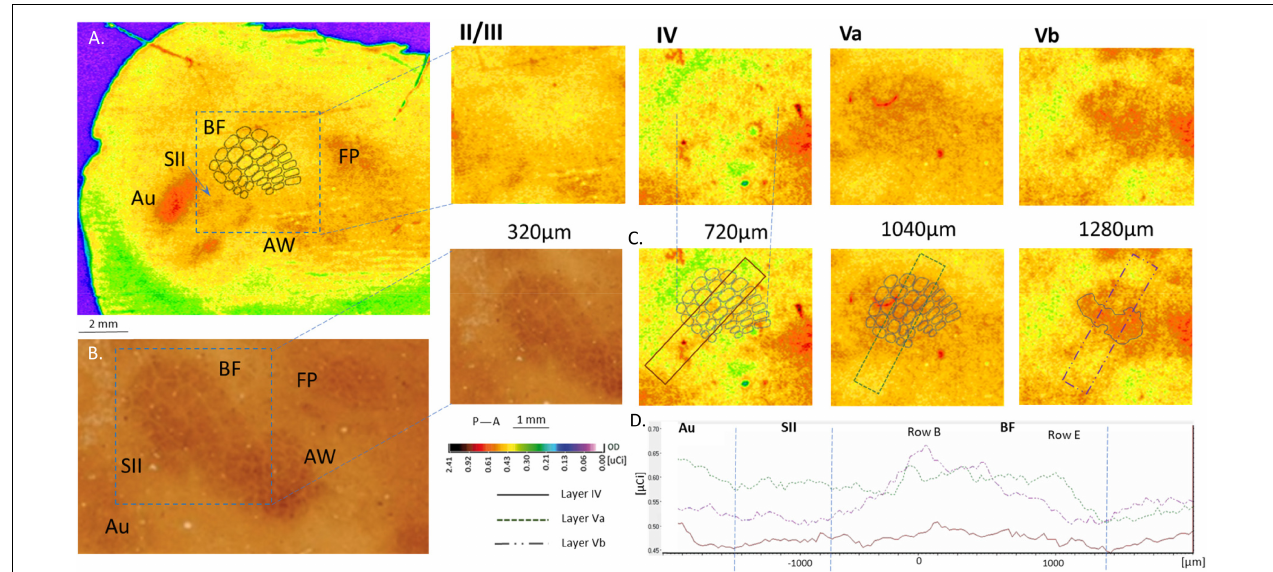
FIGURE 4 | Cortical 2DG incorporation following the ipsilateral row B whiskers stimulation shown in four layers of the barrel field cortex. (A) no response is seen in layers II/III and IV (slightly higher incorporation might be observed in deep layer IV). Layer Va shows evident excitation in the entire surface of the BF with stronger activation of row B representation in layer Vb; (B) BF in layer IV stained for cytochrome oxidase activity. (C) OD measured across the BF in layer IV, Va and Vb. (D) 2DG incorporation in the above chosen areas in the tree layers.